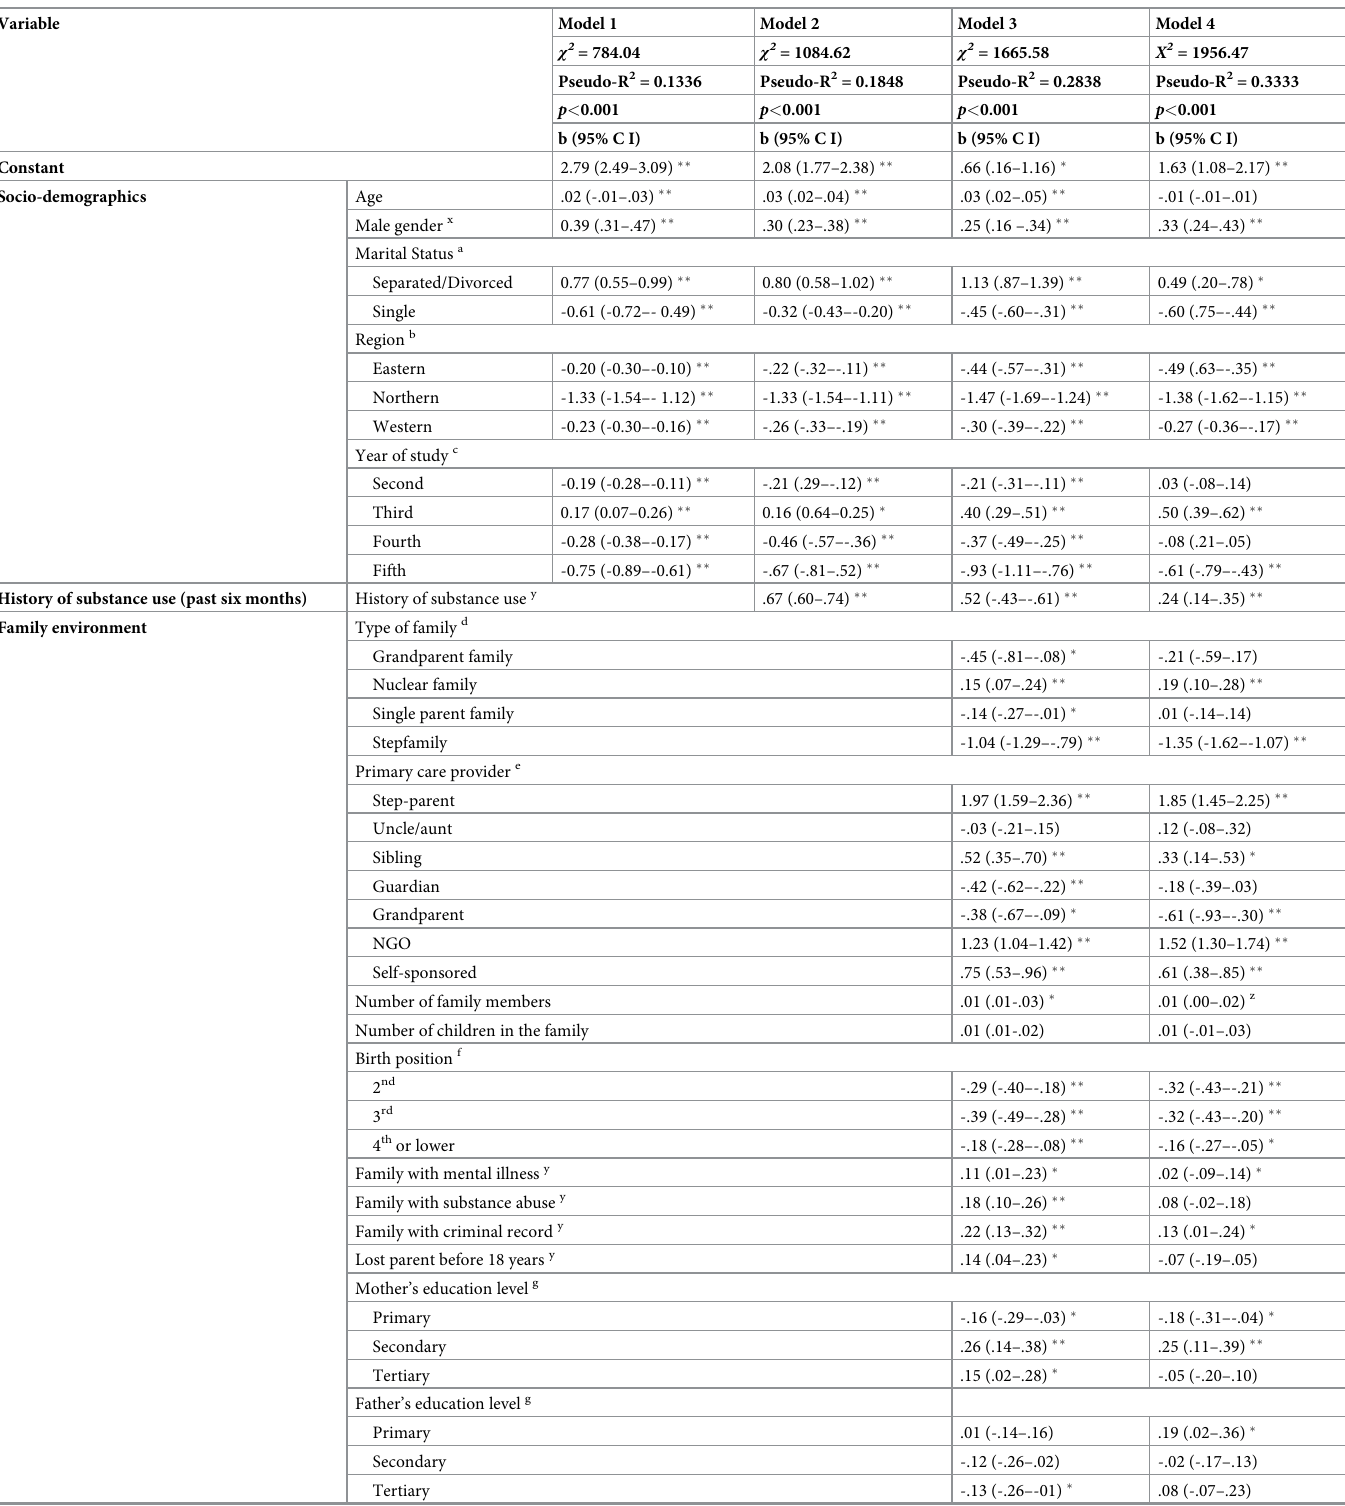
Table 3. Predictive models for risky sexual behaviour (n =